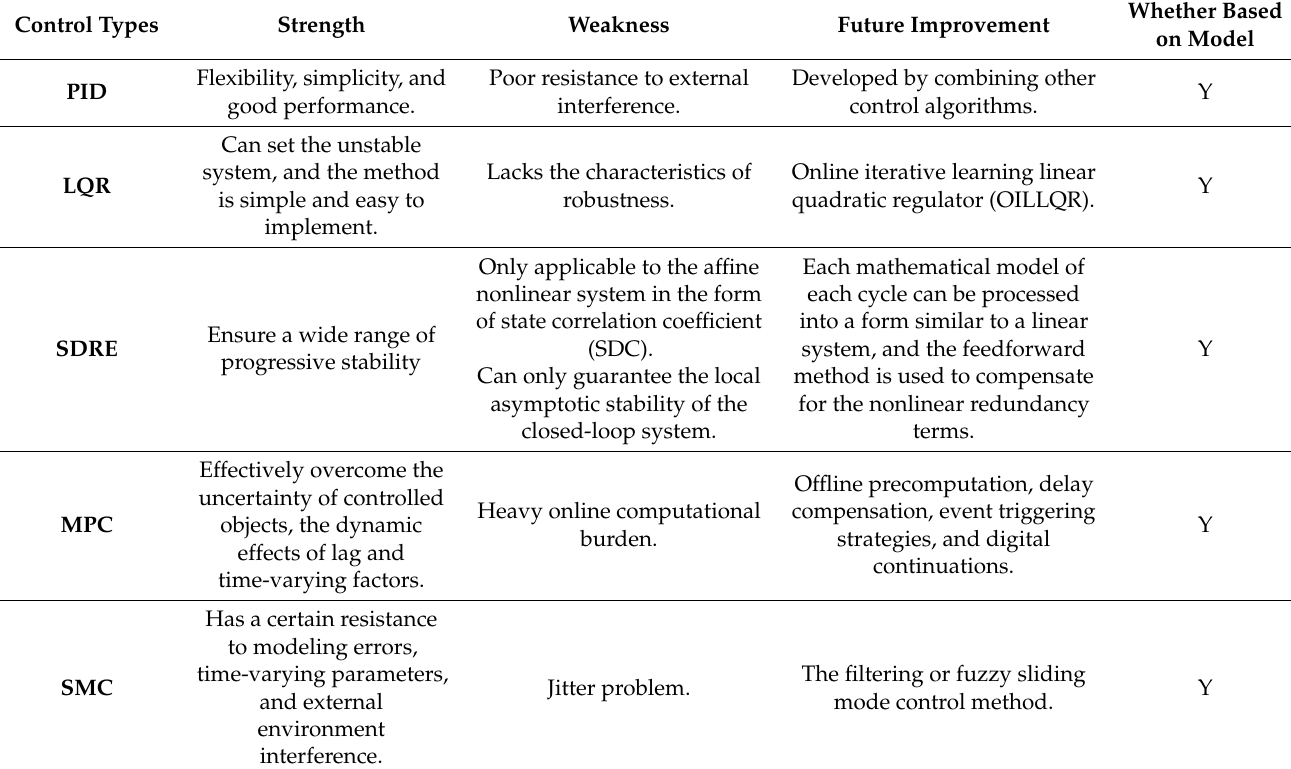
Table 6. Summary of different type of controller in trajectory tracking